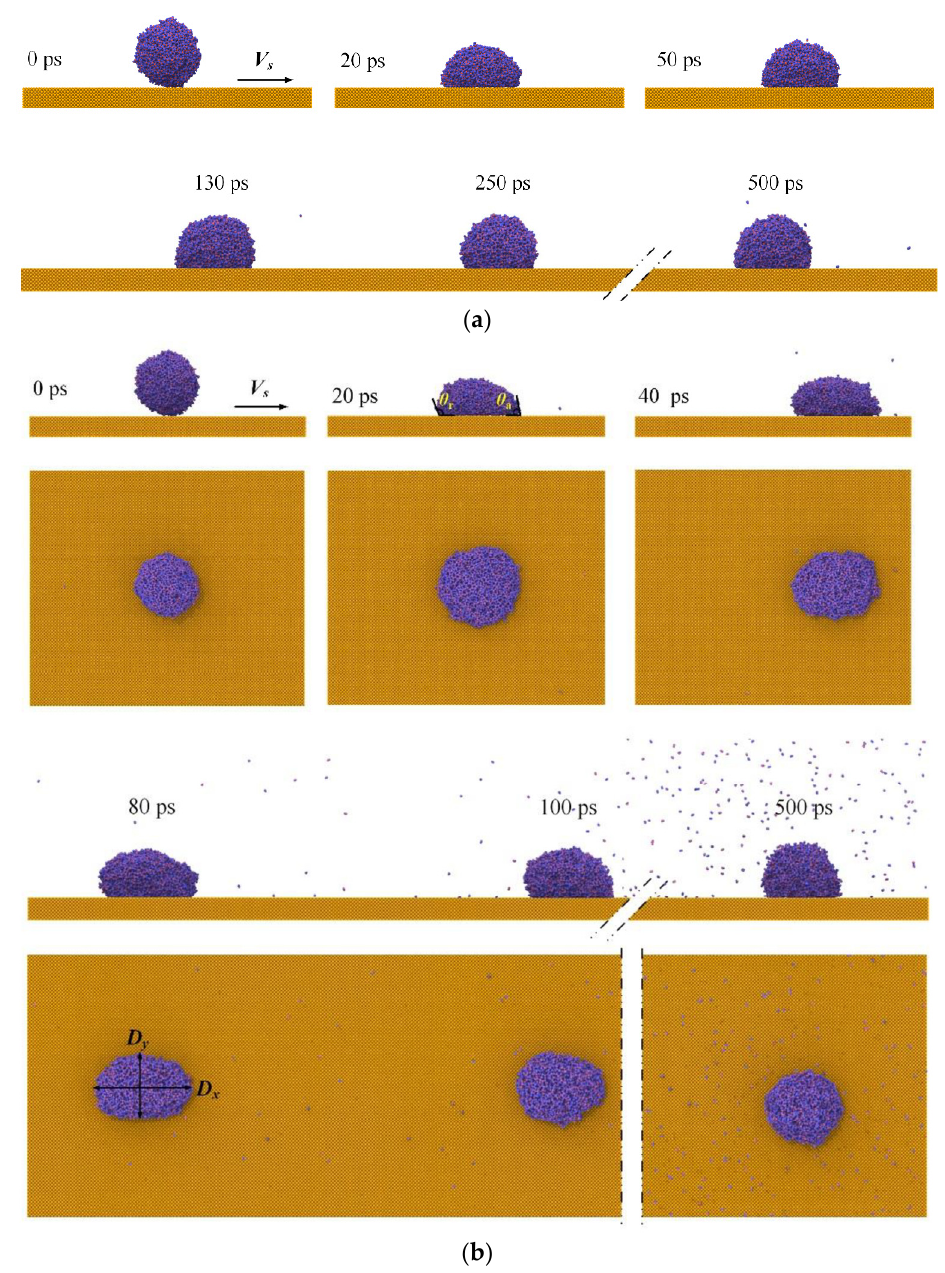
Figure 4. Morphological evolution of droplets impinging on surfaces with different translation velocities: ( a ) V s = 0.5 Å/ps; ( b ) V s = 9 Å/ps.